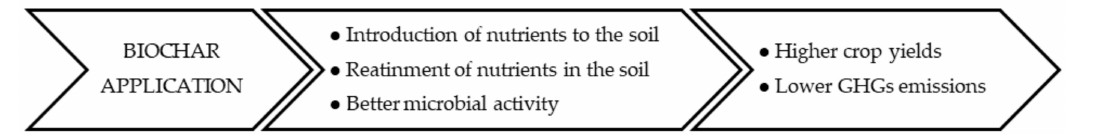
Figure 2. Summary of the overall concept of biochar application to the